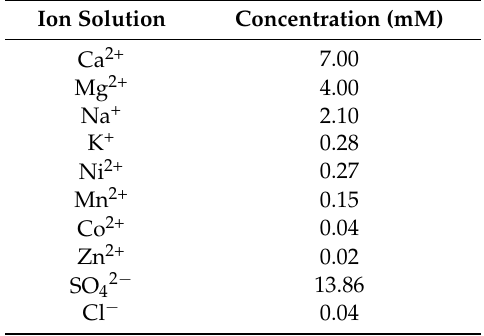
Table 1. Chemical composition of the synthetic Acid Mine Drainage (AMD) feed in the bioreactor.